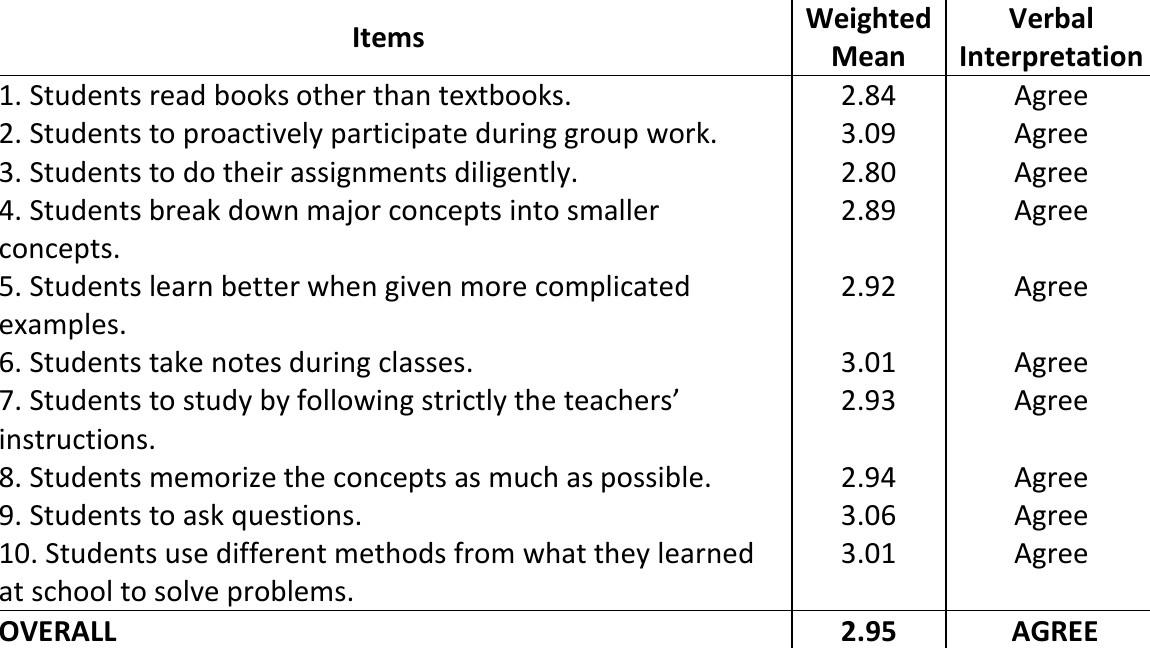
Table 5 : Weighted Means of the Factors Affecting Students’ Progress as to Study